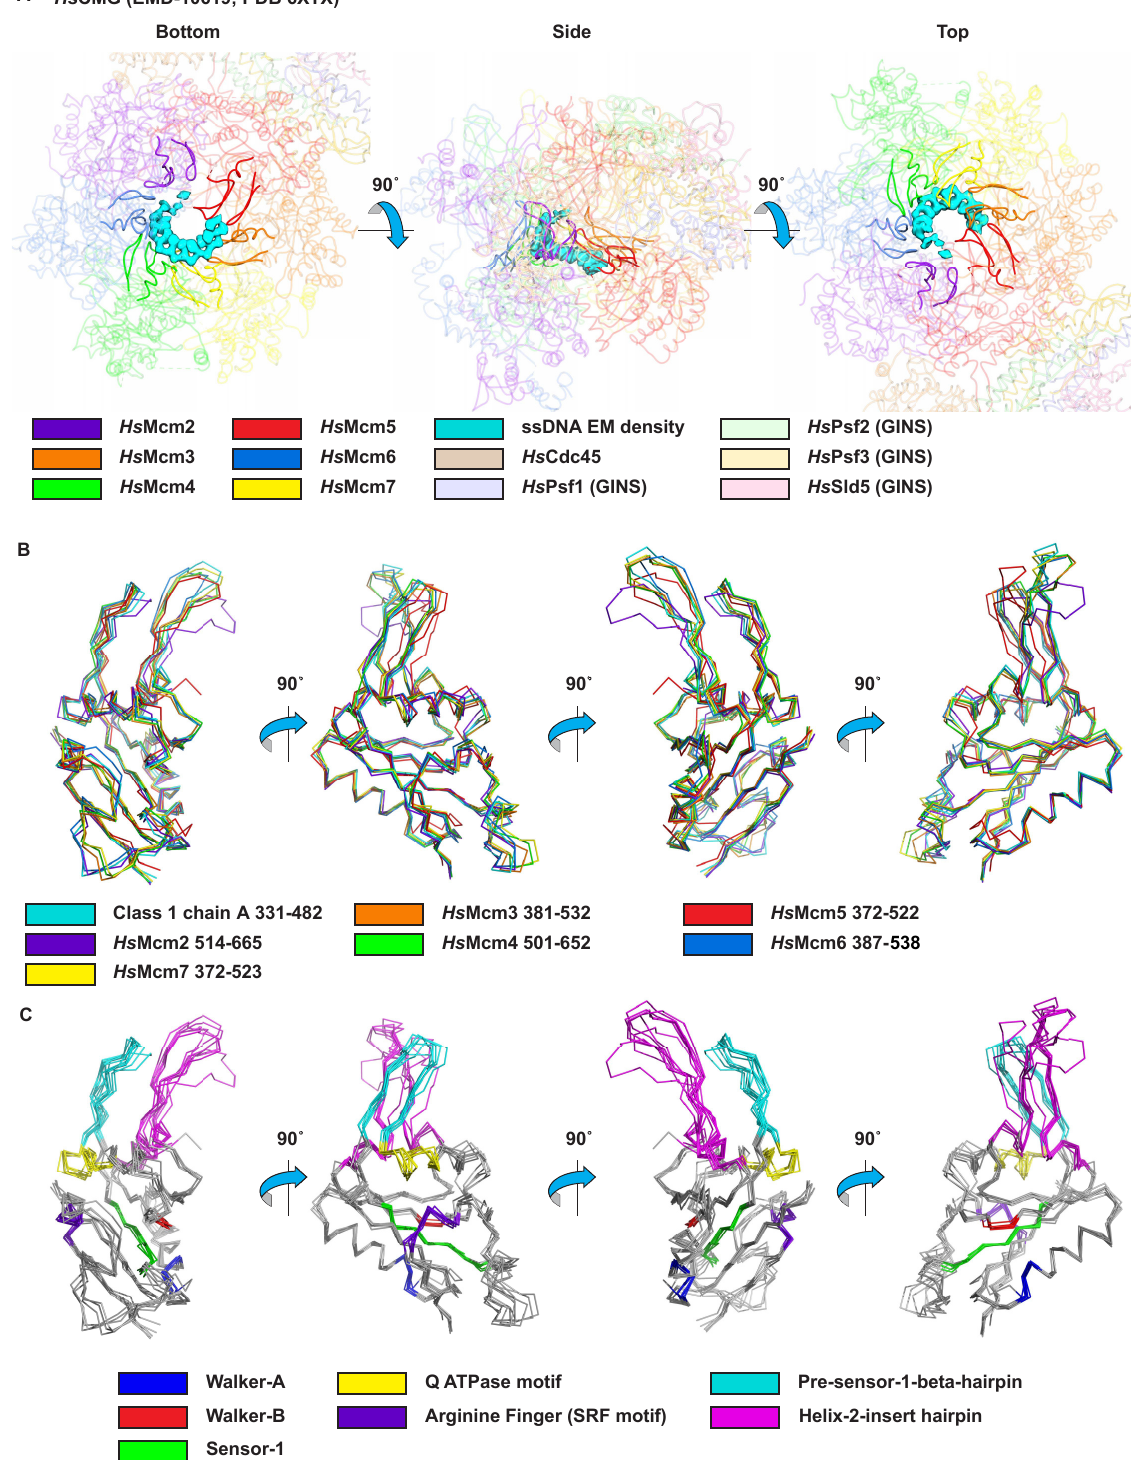
Figure 6. The core MCM ATPase domains of eukaryotes are archaea are highly similar in structure and function. ( A ) The human CMG complex binds DNA with a spiral staircase of hairpins (PDB 6XTX and EMD-10619 [22]) analogous to that of Sso MCM. Three perpendicular views are provided analogous to those of Figure 3A, illustrating highly similar ssDNA density and binding mode with the two hairpins of each subunit. The “side” view is perpendicular to the central channel with the N-terminal tier on top and the ATPase tier on the bottom. The “bottom” view is parallel to the